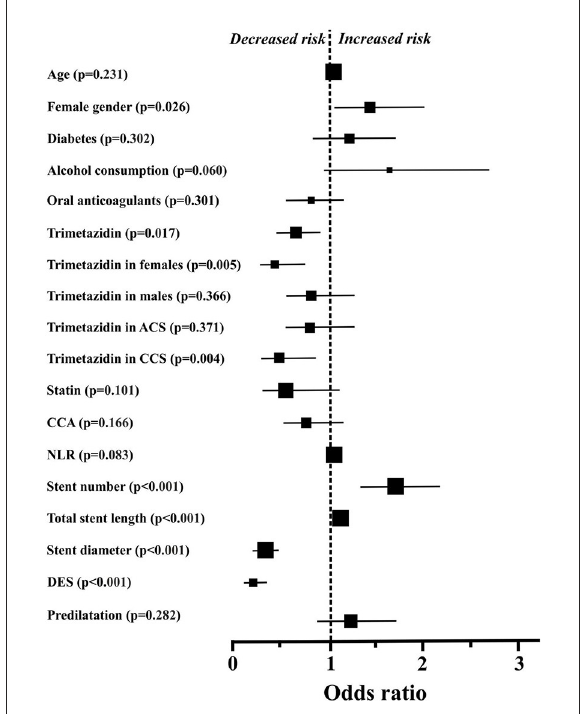
FIGURE2 Odds ratios and 95% confidence intervals for in-stent restenosis in the individual subgroups, defined based on baseline characteristics, blood chemistry, percutaneous coronary intervention-related procedural data, and drug therapy. The sizes of the symbols reflect the number of patients in each group. For some parameters (age and total stent length), confidence intervals are within the symbols. ACS, acute coronary syndrome; CCA, calcium channel antagonist; CCS, chronic coronary syndrome; DES, drug eluting stent; NLR, neutrophil to lymphocyte